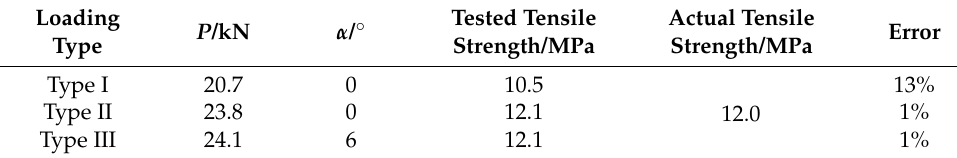
Table 2. The tensile strength and error of three loading